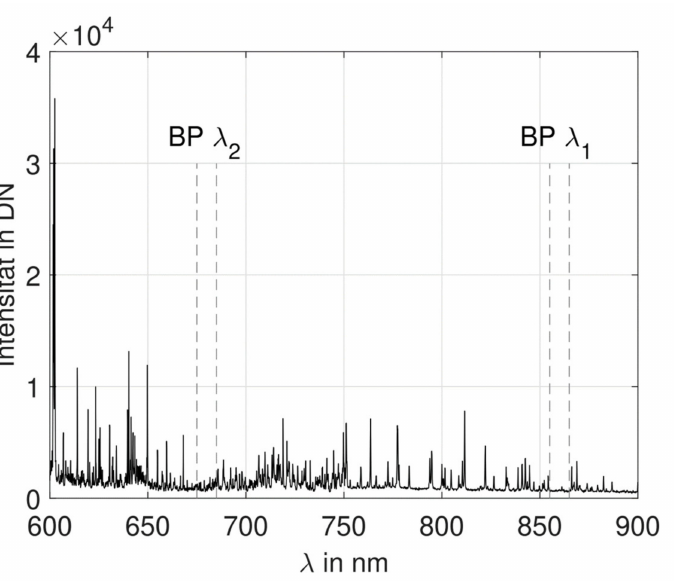
Figure 14. Partial spectrum from 600 nm to 900 nm of arc plasma with the selected band passes plotted [26].